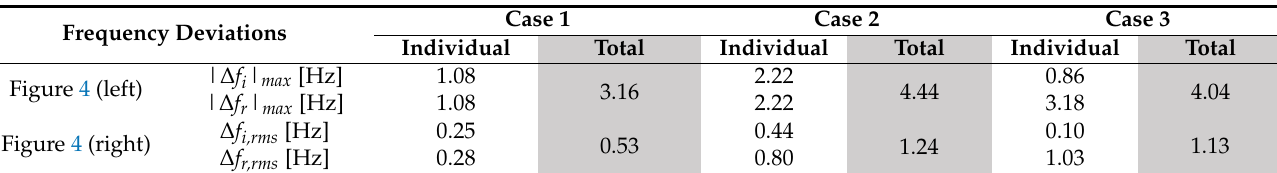
Table 4. Comparisons of the results for the step and continuous response